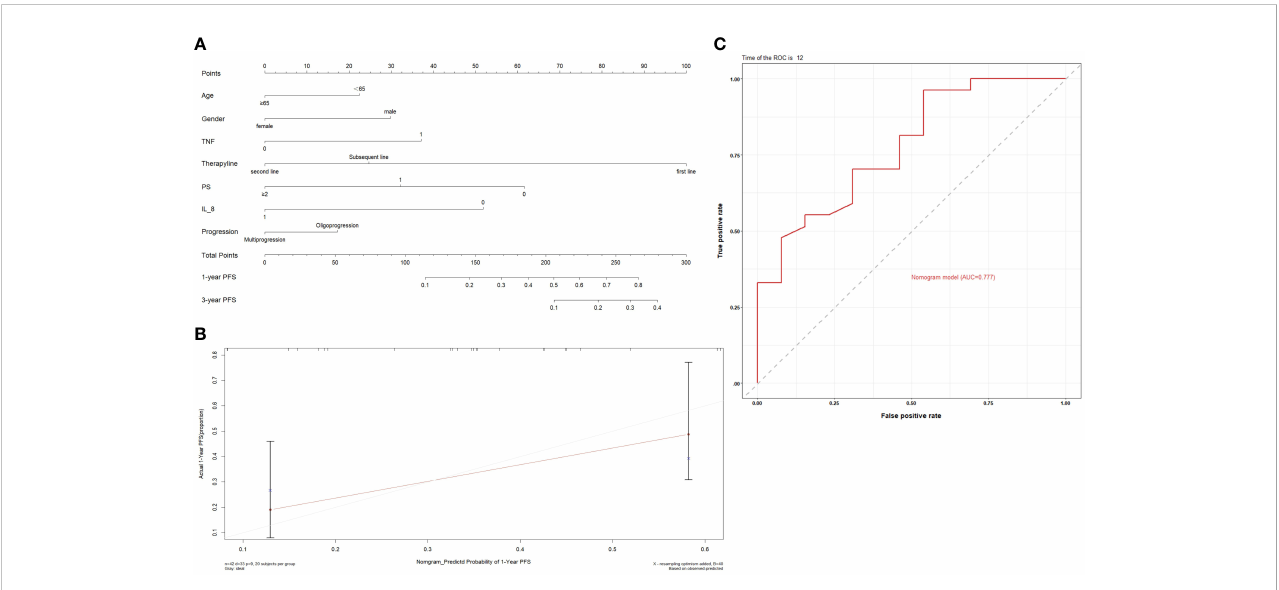
FIGURE 12 (A) Prognostic nomograms for predicting the PFS probabilities of patients; (B) Calibration curve of the prediction model; (C) ROC curve of the prediction